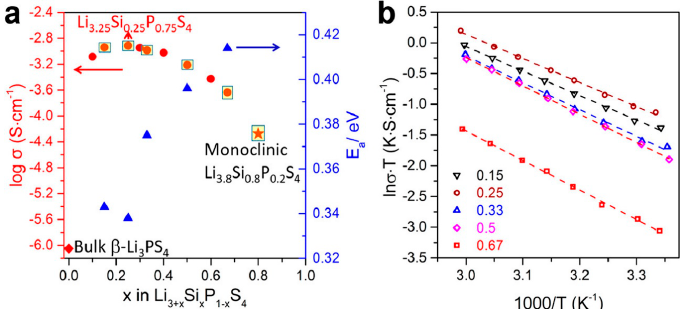
Figure 13. ( a ) Ionic conductivity (red dots) at room temperature and activation energy ( E a ) (blue triangles) of Li 3+ x [Si x P 1 − x ]S 4 as function of the Si content ( x ); the squares around the data points indicate the compositions for which the structure has been solved using single crystal diffraction. ( b ) Arrhenius plots of Li 3+ x [Si x P 1 − x ]S 4 ( x = 0.15, 0.25, 0.33, 0.5, 0.67). Reproduced with permission from [222]. Copyright 2019 American Chemical Society.